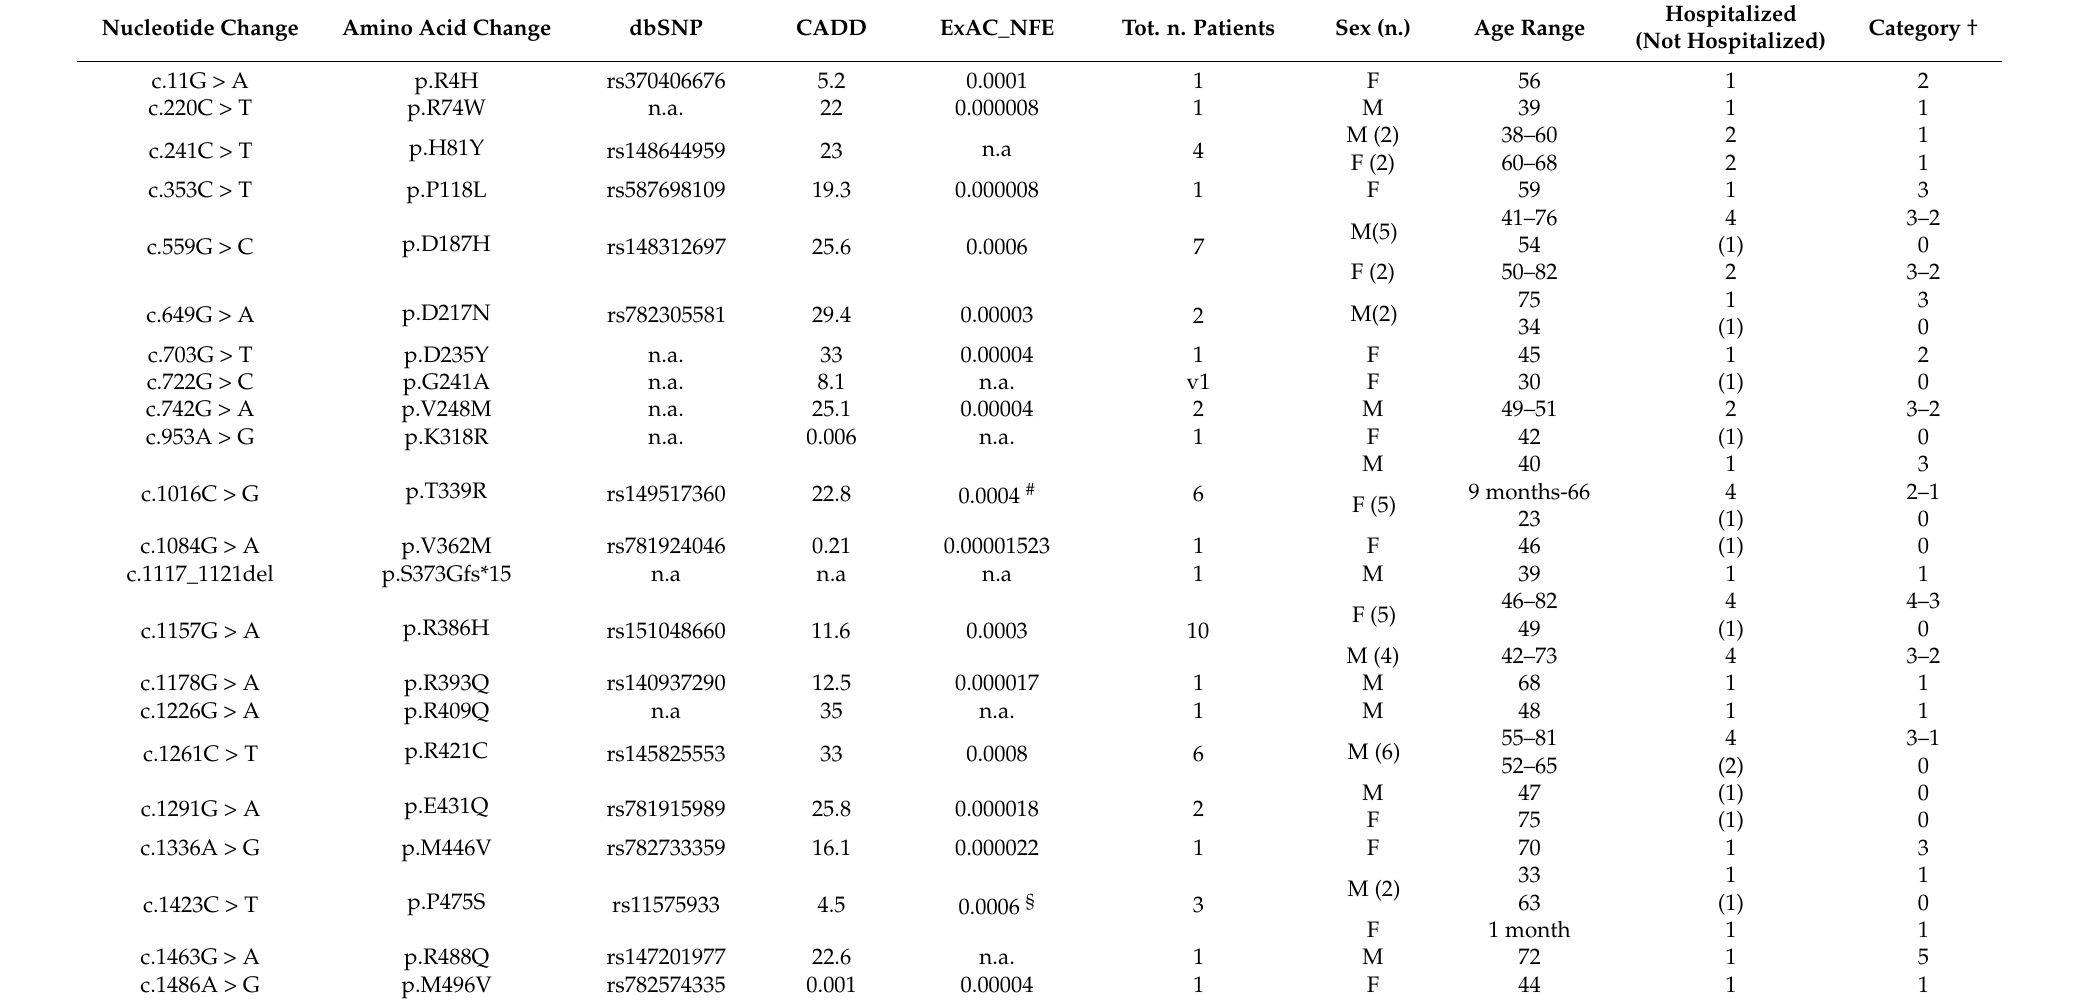
Table 2. ADAMTS13 heterozygous mutations in the entire cohort of SARS-CoV-2 positive